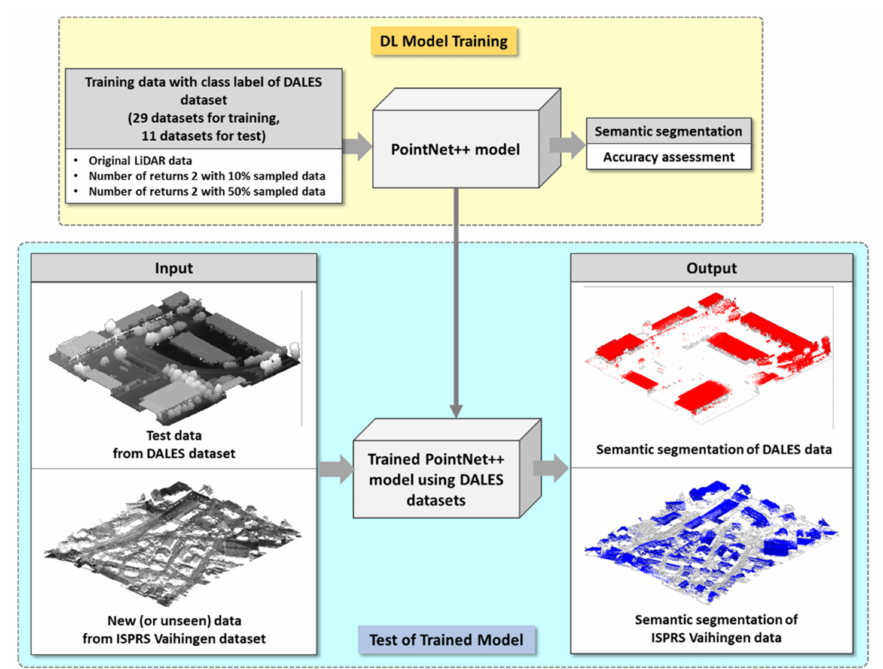
Figure 11. Workflow of the proposed method.